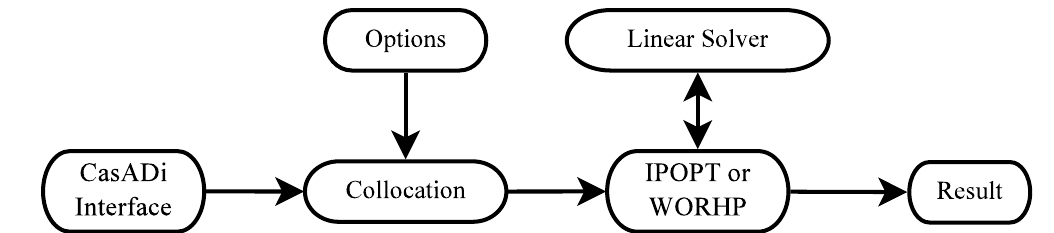
Figure 3. The framework surrounding the implemented collocation framework in JModelica.org. The framework starts with a representation of the DOP in CasADi Interface generated by the compiler. The DOP is then discretized by the collocation framework into an NLP, which is solved by either IPOPT or